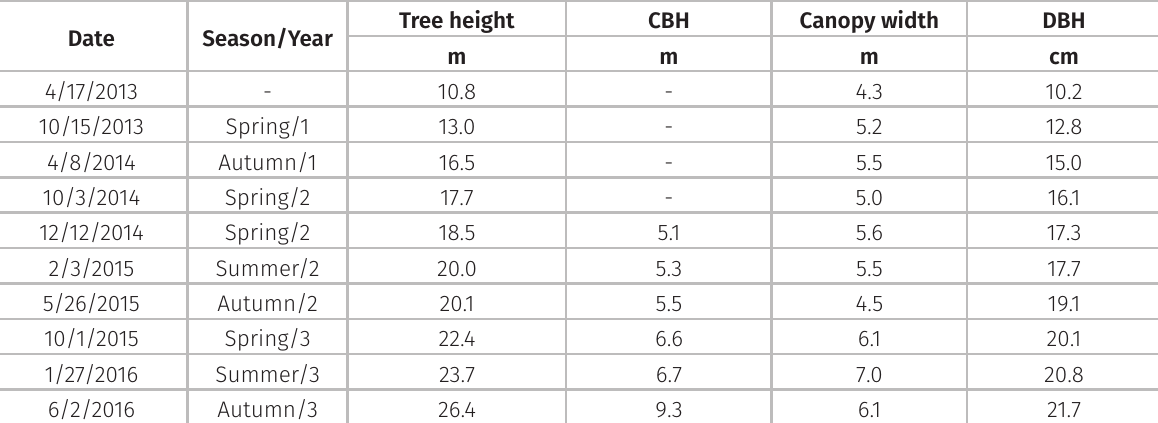
Figure 2. Weather measurements during the three years of the study Table I. Tree height, crown base height (CBH), canopy width, and diameter at breast height (DBH) of trees, in a silvopastoral system, measured in several dates of each study year.